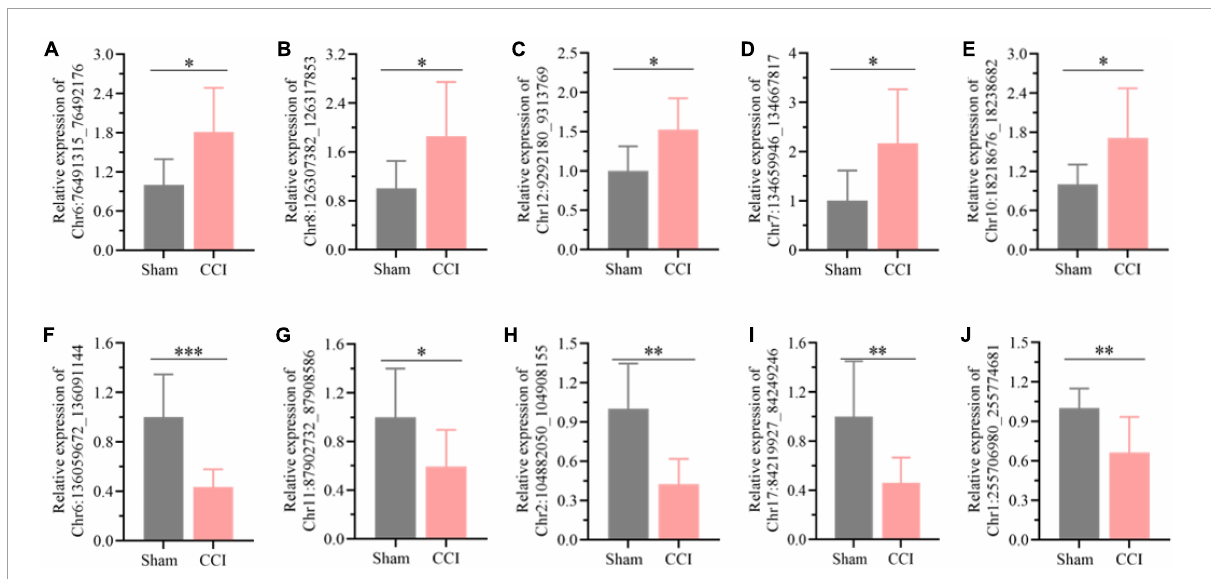
FIGURE3 Detection of the typical differentially expressed circRNAs by qRT-PCR. (A) Chr6:76491315_76492176 , (B) Chr8:126307382_126317853, (C) Chr12:9292180_9313769, (D) Chr7:134659946_134667817, (E) Chr10:18218676_18238682, (F) Chr6:136059672_136091144, (G) Chr11:87902732_87908586, (H) Chr2:104882050_104908155, (I) Chr17:84219927_84249246, (J) Chr1: 255706980_255774681 . Error bars represent the mean ± SD ( n = 8), and the statistical analysis was conducted via unpaired Student’s t -test. ∗ P < 0.05, ∗∗ P < 0.01, ∗∗∗ P <